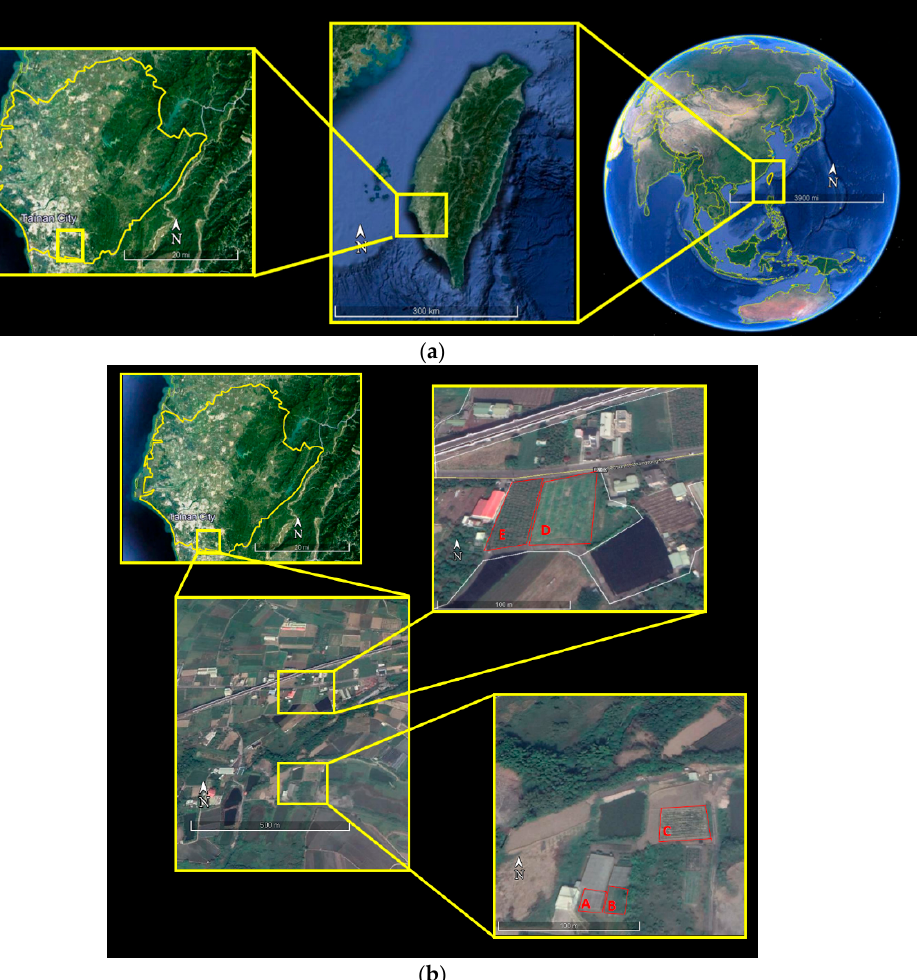
Figure 1. Location of study area: ( a ) Tainan City, Guiren district, and ( b ) farmlands in the present study (A, B, C, D, and E) (Google Earth Pro 7.3.3.7786 (2021)). Table 2. Farmlands characteristics in the study area.